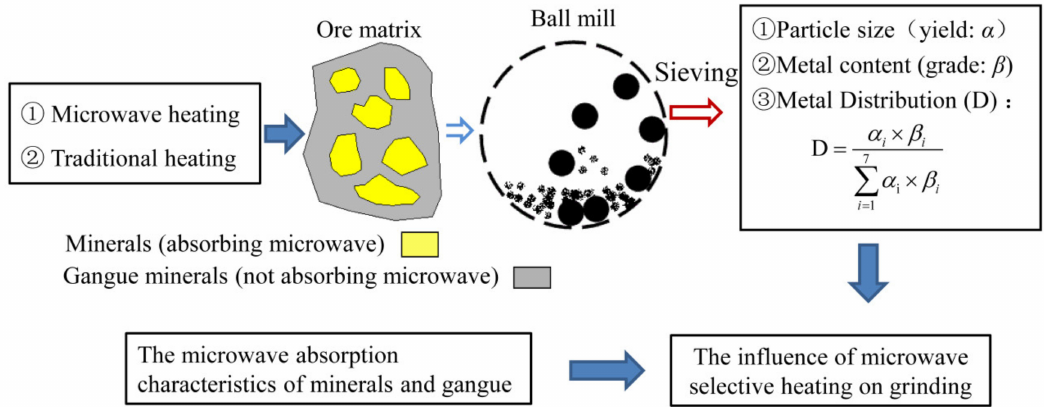
Figure 1. Flow diagram of the microwave heating and grinding.